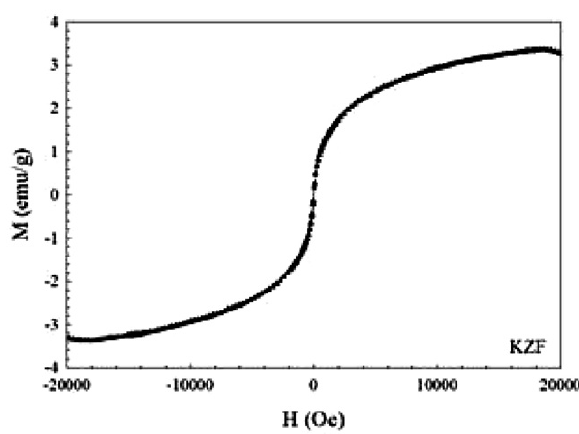
Fig. 4. VSM analysis of KZF at room temperature performed at an initial dye concentration of 30 mg/L, with an adsorbent amount of 0.6g/200mL, at 21 °C and original solution pH of ≈7.4. As seen in Fig. 5, lower removal rates were obtained for both DR-28 and DB-22 in the experi- ments with kaolin compared to those with KZF and KZF-